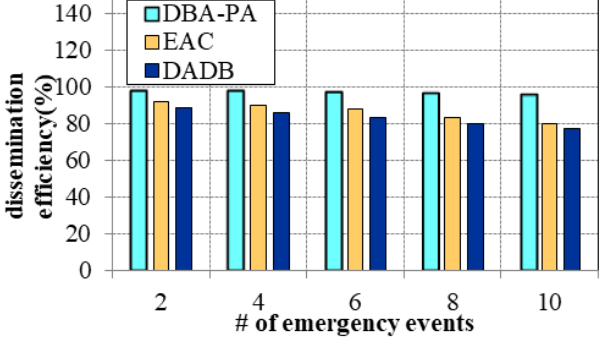
Figure 14. Number of Vehicles vs. Safety Scores.